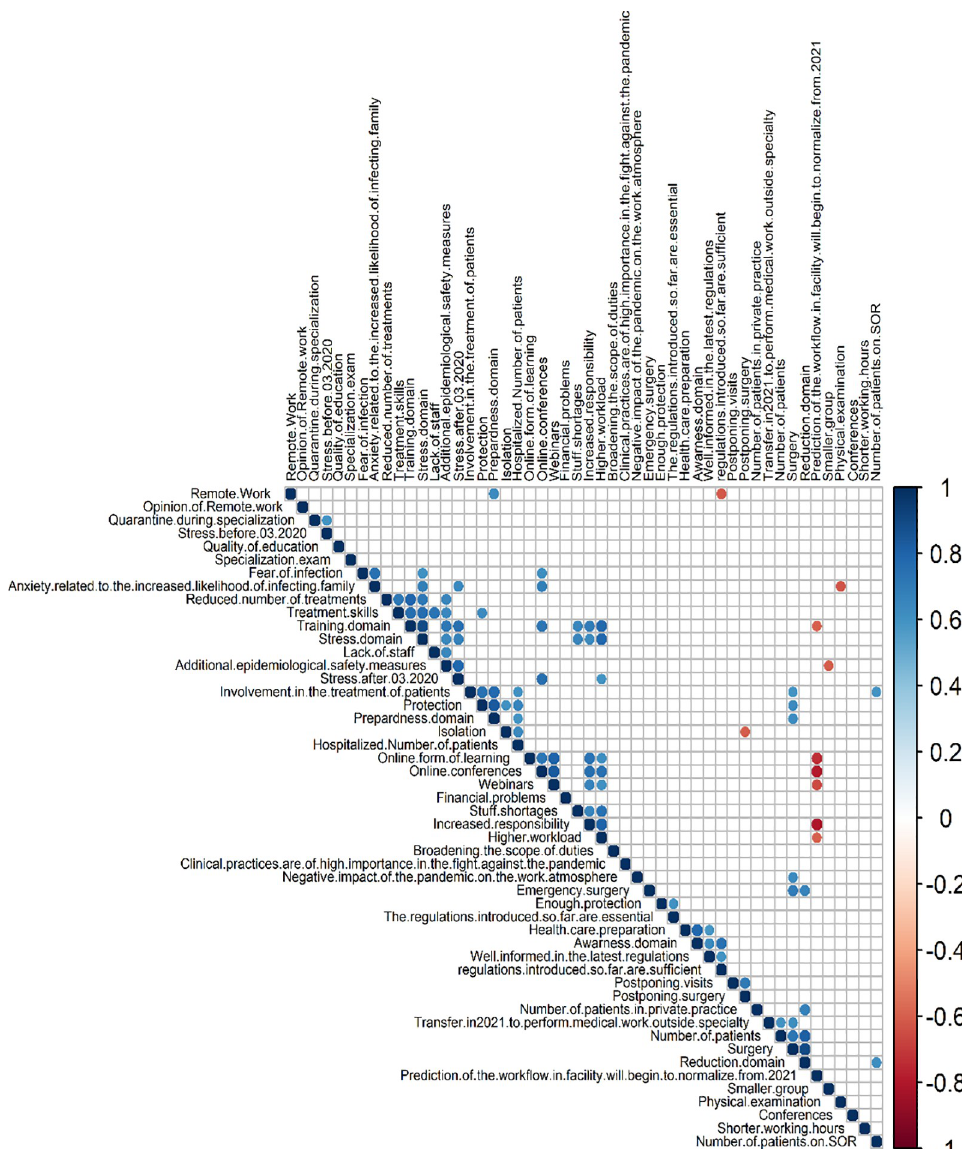
Fig 2. Correlation matrix. The figure shows a map of the Spearman correlation between the different profile items and the calculated indices. Red boxes presented a negative correlation (Spearman r < 0), blue boxes presented a positive correlation (Spearman r < 0), blue boxes presented a positive correlation (Spearman r > 0), darker colors represent stronger correlation, and white or light-colored boxes no or weak